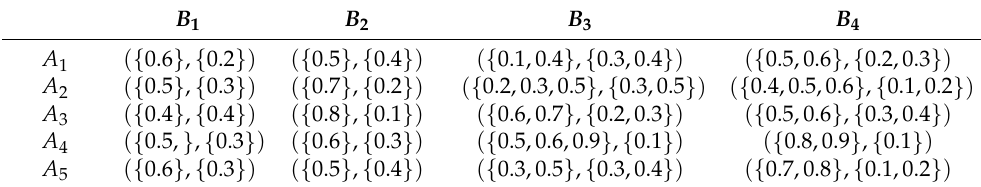
Table 1. Decision set.